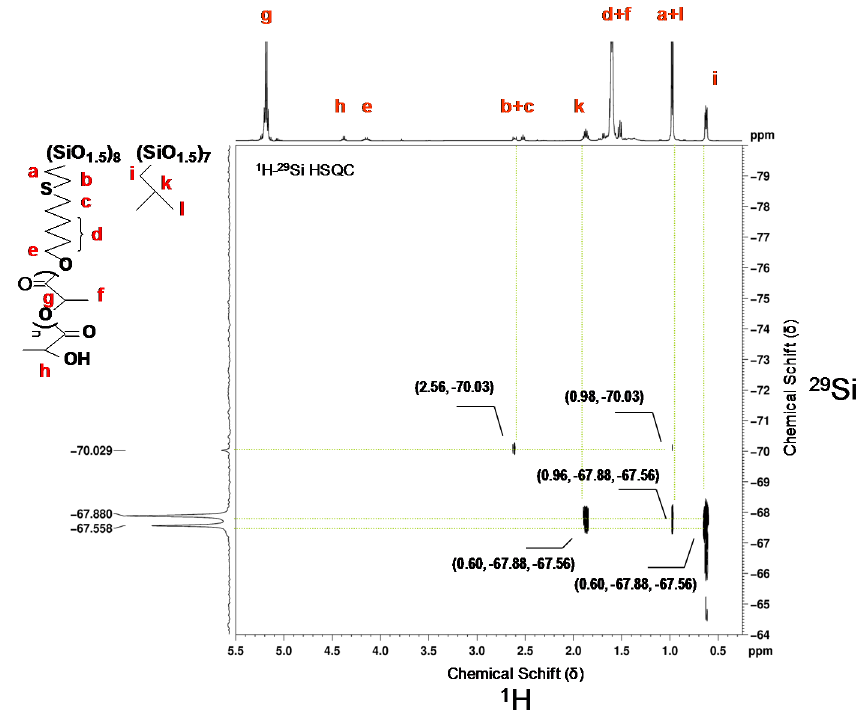
Figure 7. The 1 H– 29 Si HSQC NMR spectrum of star-shaped (iBu-POSS-S-PLA)(7)